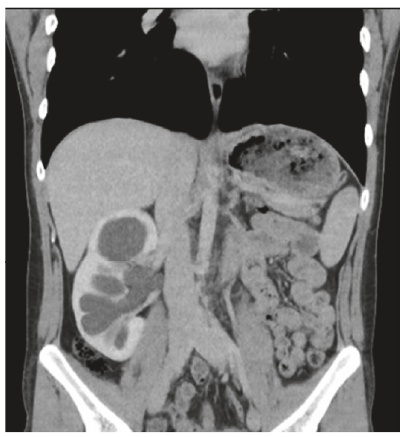
Figure 1: UPJO in solitary kidney with intrarenal pelvis in urography images by CT scan.